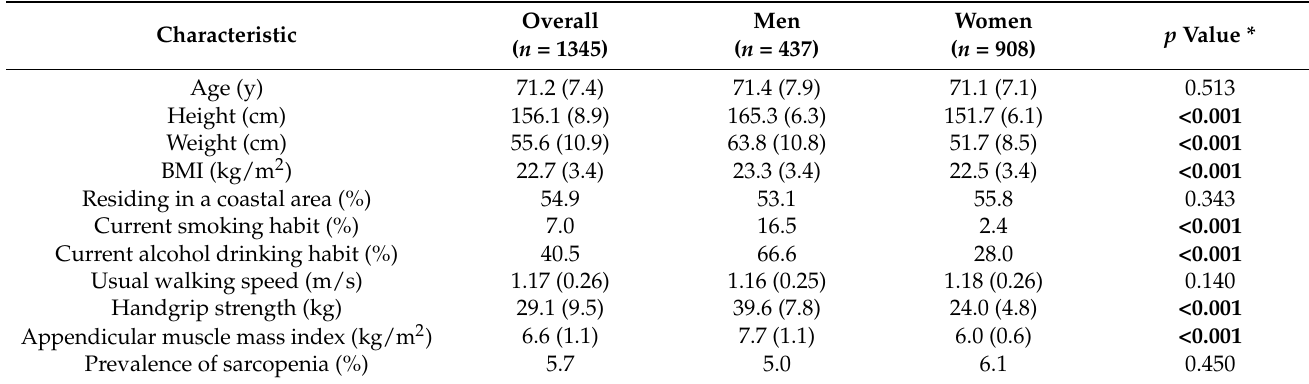
Table 1. Baseline characteristics of participants.